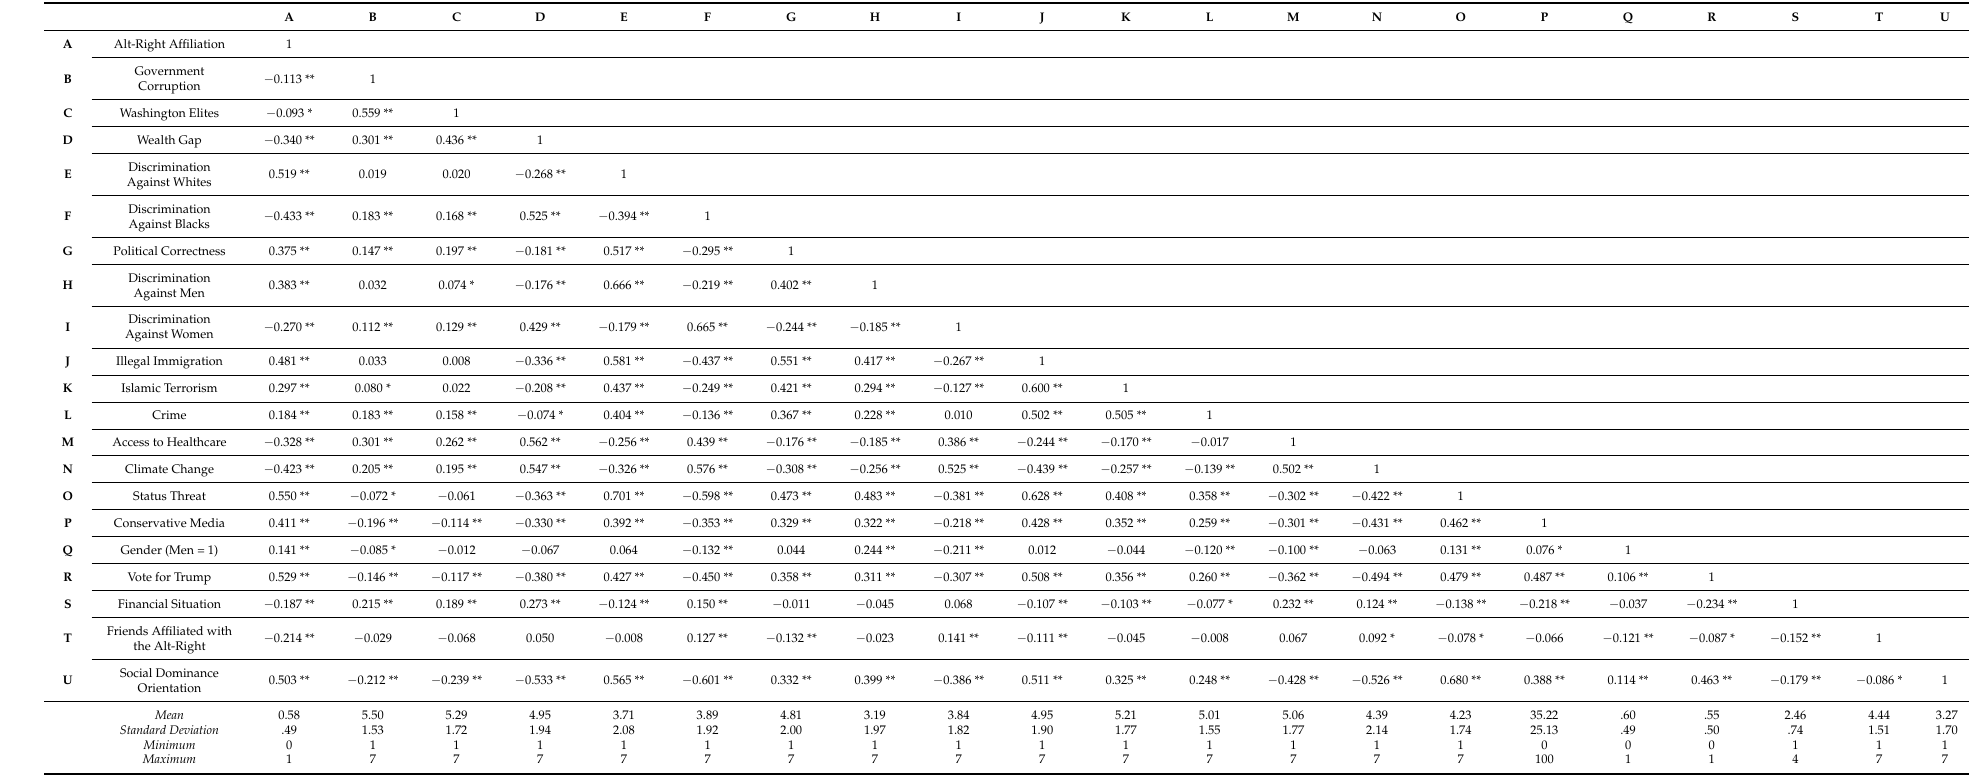
Table 1. Correlation Matrix and Descriptive